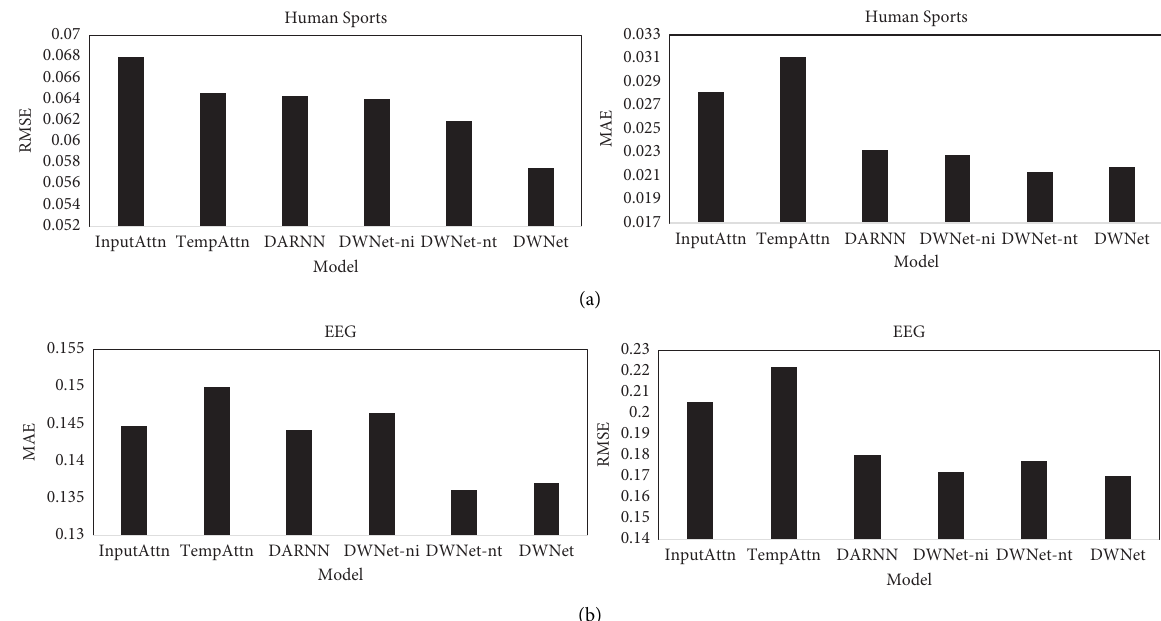
Figure 3: Performance of different methods in Human Sports and EEG. (a) RMSE and MAE versus different methods over Human Sports. (b) RMSE and MAE versus different methods over EEG.